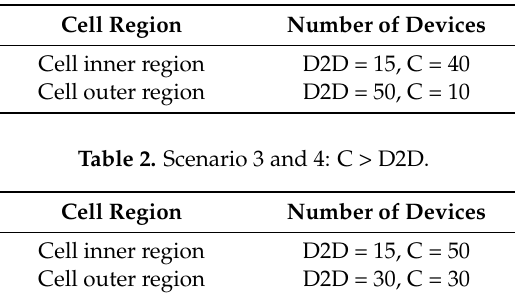
Table 1. Scenario 1 and 2: D2D > C.